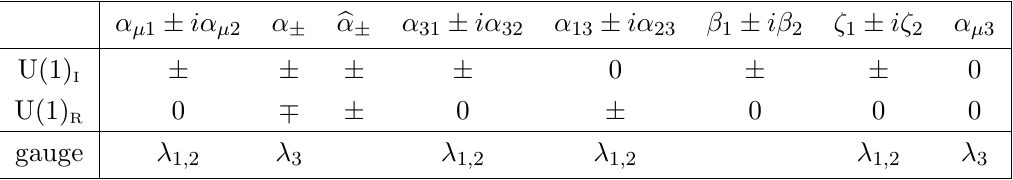
Table 2. Charges (divided by two) of the (cid:13)uctuations under the relevant Abelian global symmetries. holographic